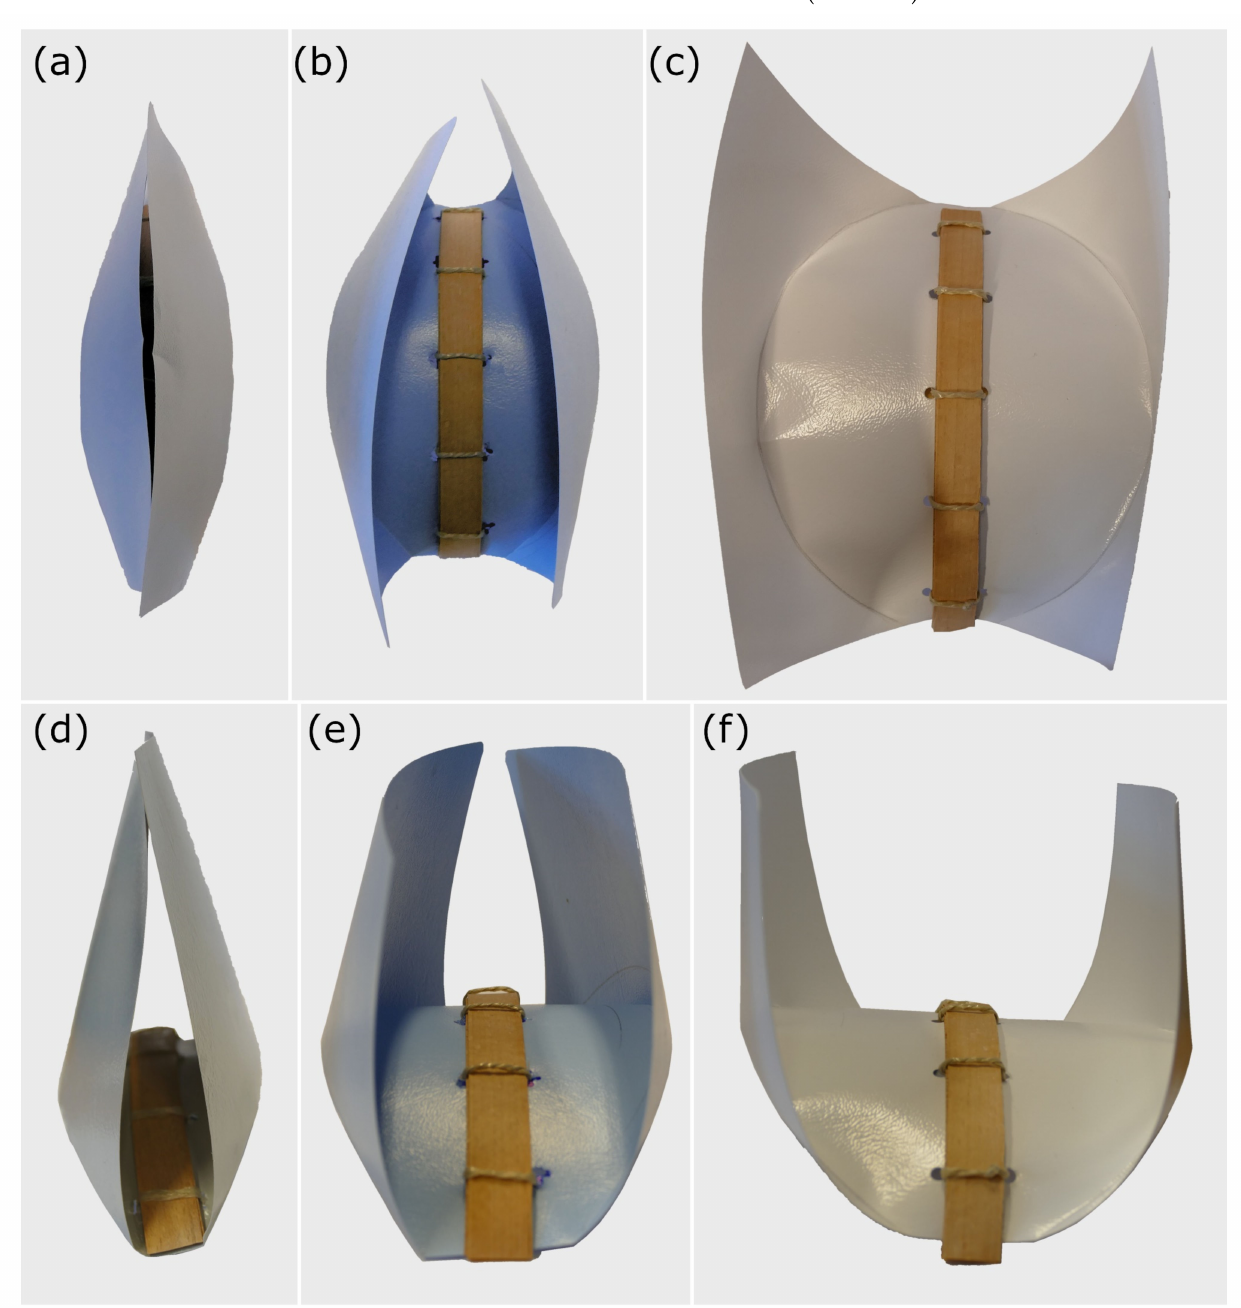
Figure 17. Top and side view of various Flectofold-like structures after the completed movement. The positive correlation between the radius of curvature and the maximal closing angle of the “wings” can be easily discerned. Radius of curvature: ( a , d ) 190 mm, ( b , e ) 150 mm, and ( c , f ) 120